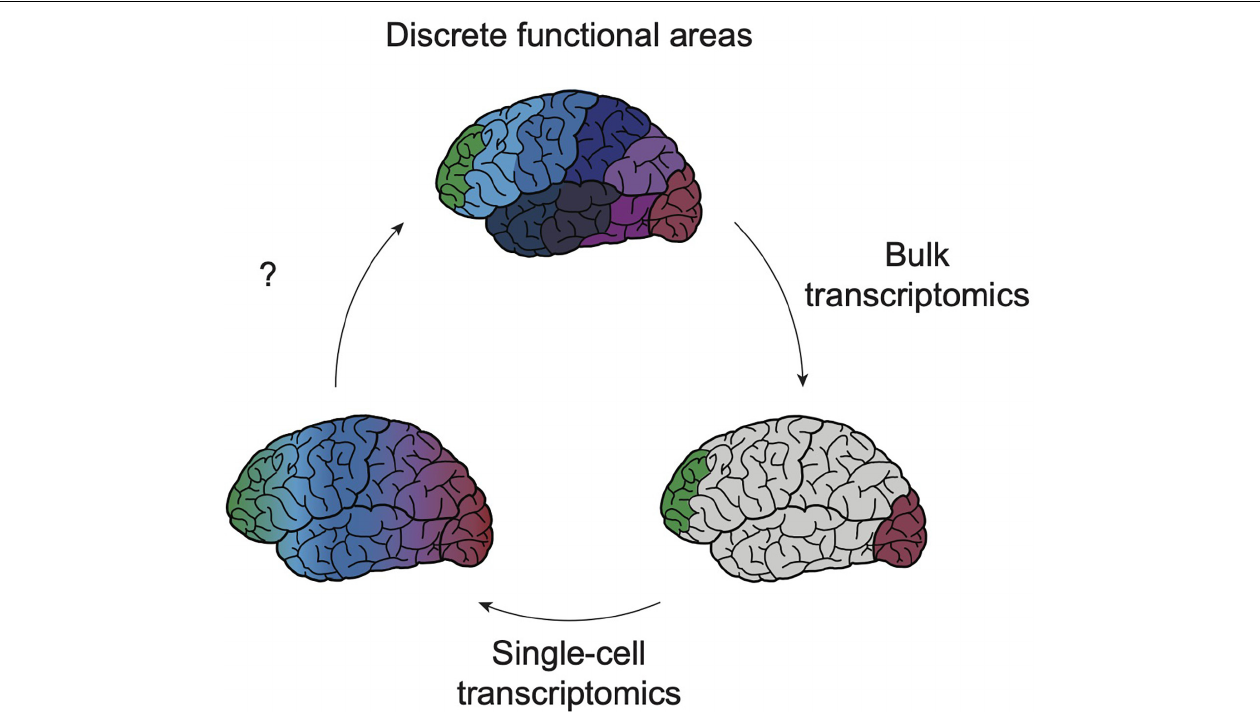
FIGURE 1 | Exponential resolution of transcriptomic profiling shaped understanding of cortical boundaries. Early profiling efforts of bulk tissue (bottom right schematic) from various cortical areas have suggested that, with the exception of the poles of the cortex (green, red) the majority of cortical areas share a largely consistent transcriptomic profile (gray). Single-cell transcriptomics has sought to increase the resolution of these profiling techniques, enabling the detection of transcriptomic profiles of cell type-specific areal signatures and of rare cell types (bottom left). However, these next-generation datasets continue to show the subtlety of transcriptomic heterogeneity between cortical areas, suggesting that gene expression differences between these regions exist across a continuum. Future work using human model systems will continue to refine our understanding of how these blurry boundaries ultimately yield discrete functional properties